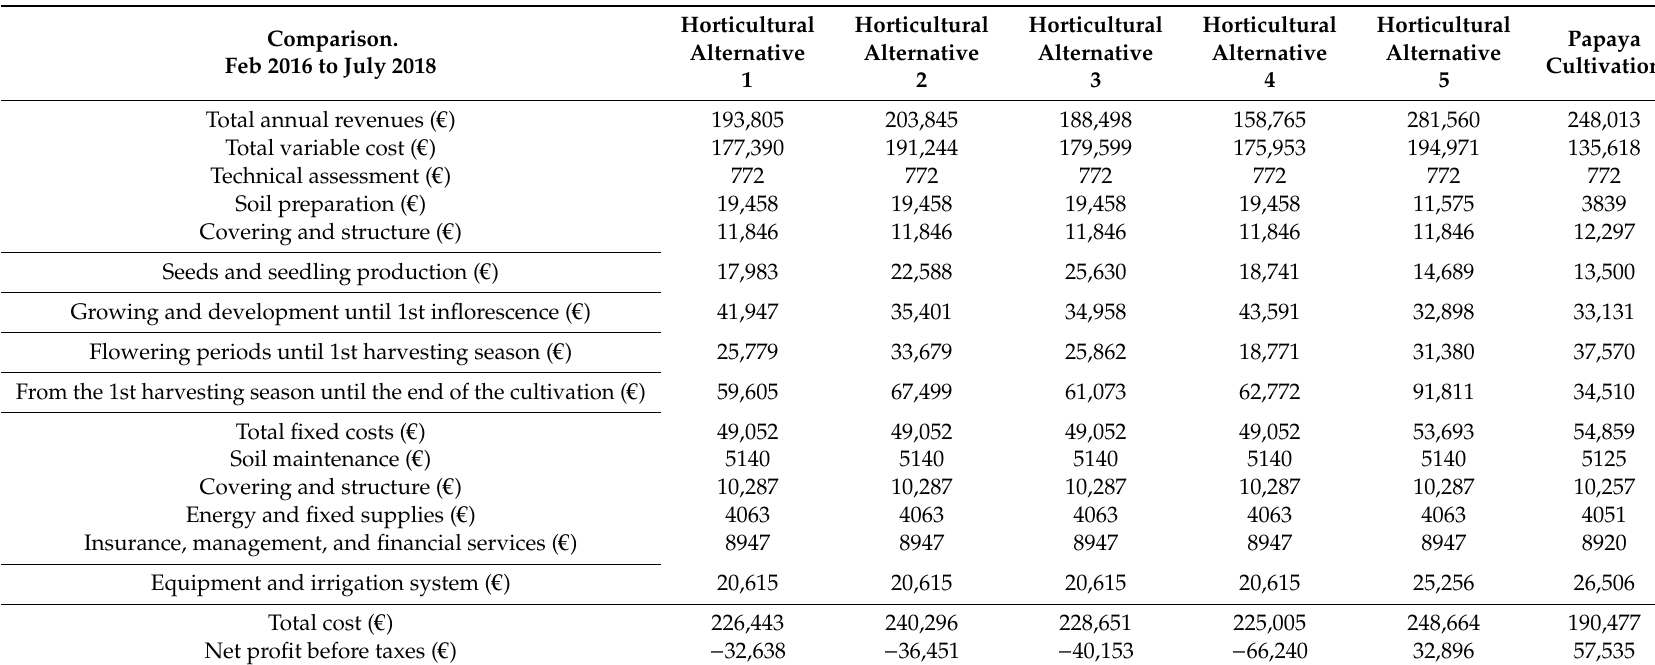
Table 4. Structure of revenues and costs per hectare of five horticultural alternative crops versus papaya cultivation, analyzed from February 2016 to July 2018.